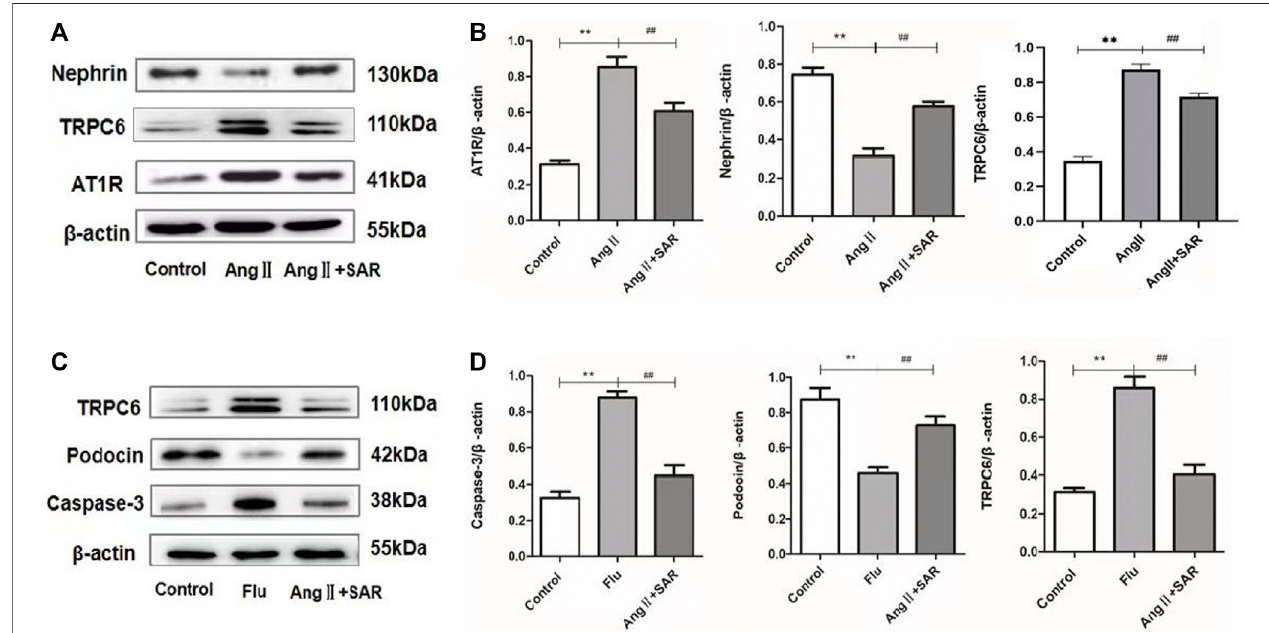
FIGURE 6 | Relative expression levels of different proteins in podocytes. (A) Expressions of AT1R, TRPC6, and Nephrin in control, Ang Ⅱ , and Ang Ⅱ + SAR podocytes. (B) The ratio of AT1R, TRPC6, and Nephrin protein expressions to the internal reference β -actin. (C) Expressions of caspase-3, Podocin, and TRPC6 in control, Flu, and Ang Ⅱ + SAR podocytes. (D) The ratio of caspase-3, Podocin, and TRPC6 protein expressions to the internal reference β -actin. (Compared with the control group, ** p < 0.01, compared with Ang Ⅱ /Flu group, ## p <